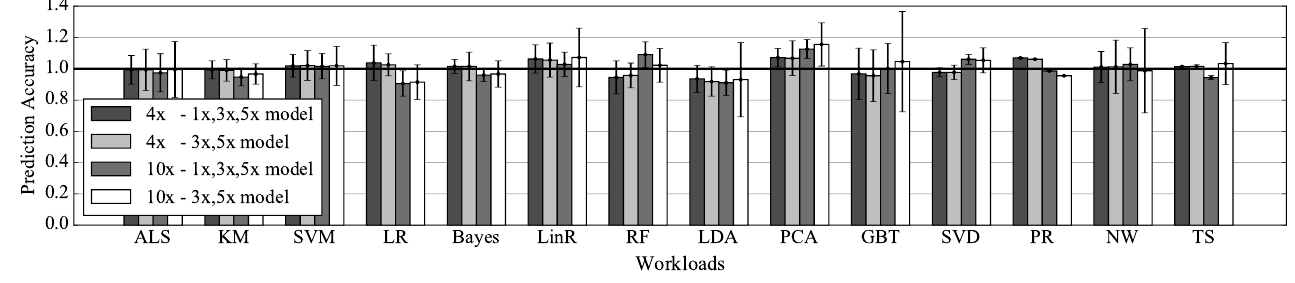
Figure 7. Prediction accuracy of two models according to the input data size for evaluation. Predictions of the cost model trended with three data are within 19% of the actual execution time when using interpolation, and within 23% of the actual execution time when using extrapolation. Predictions of the cost model trended with two data are within 19% of the actual execution time when using interpolation, and within 38% of the actual ex- ecution time when using extrapolation. In the case of interpolation, there is little difference between the prediction accuracy of the two models. However, in the case of extrapolation, predictions of the two models are noticeably different. It can be seen that the trend line equation obtained from the two data has limitations as the size of input data goes out from the range of the data. The accuracy of the cost model trended with two data indicates that the model could not be used to predict caching benefit for some workloads, such as GBT. Thus, CCA’s cost model is built using values measured from three sizes of